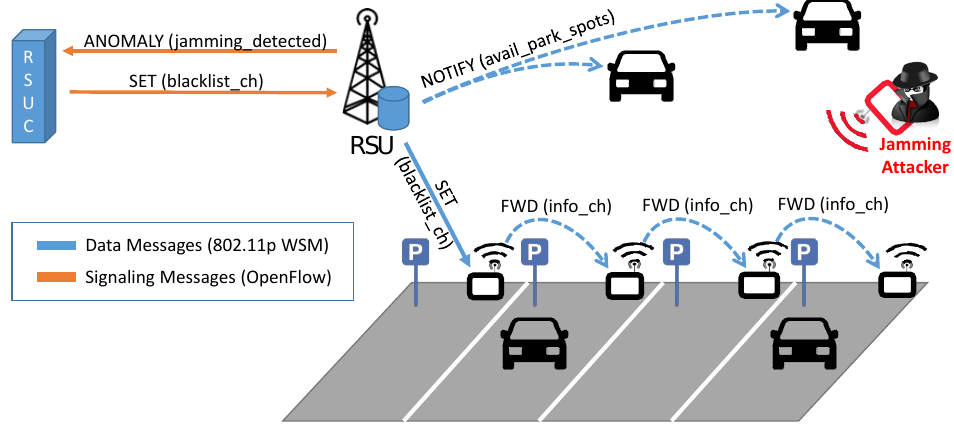
Figure 5. Jamming attack on a smart